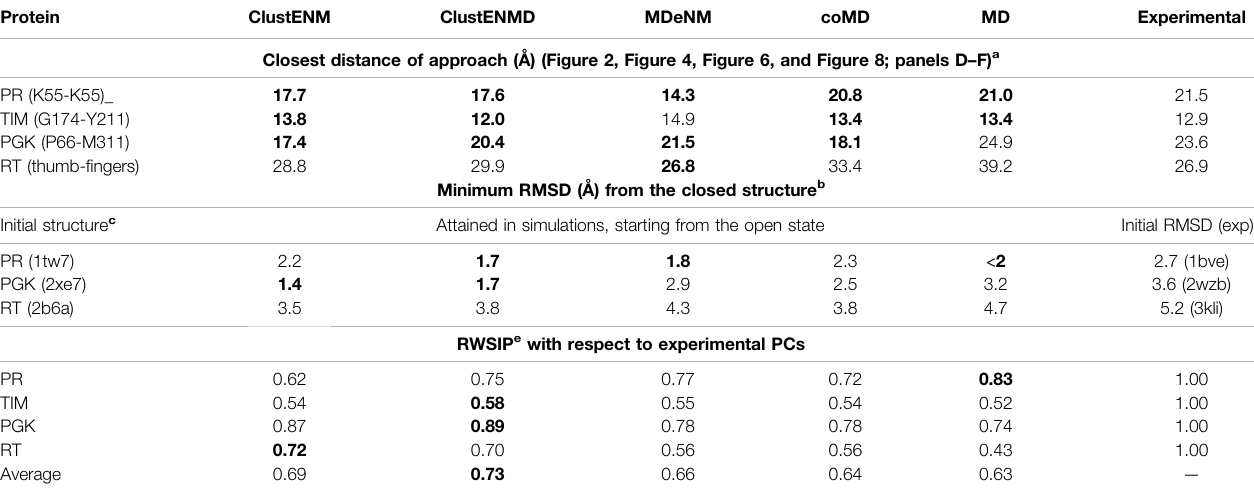
TABLE 3 | Comparative assessment of the performance of hybrid methods. Protein ClustENM ClustENMD MDeNM coMD MD Experimental